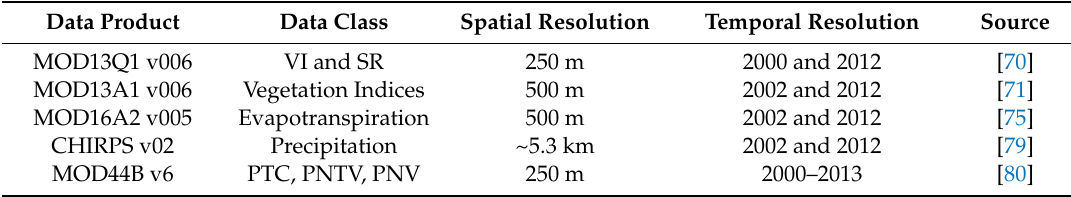
Table 3. Product specification of remote sensing